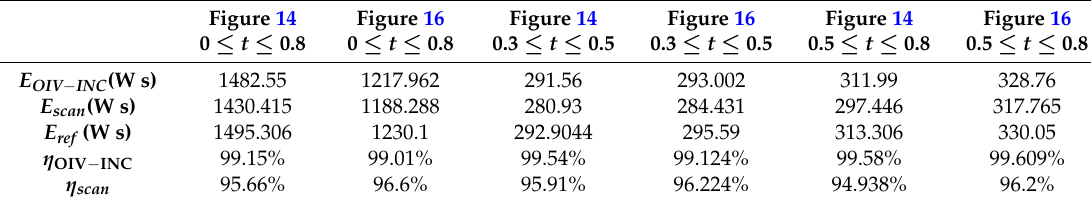
Table 4. Calculated results of efficiency in partial shading